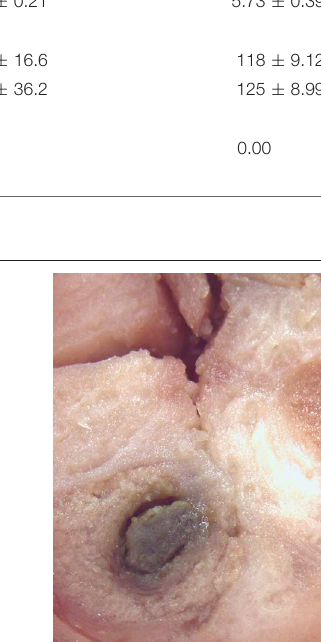
TABLE 3 | Physicochemical characteristics of the chyme in the TI and in the cecum, in relation to the dietary treatments. Diet FP Number of animals